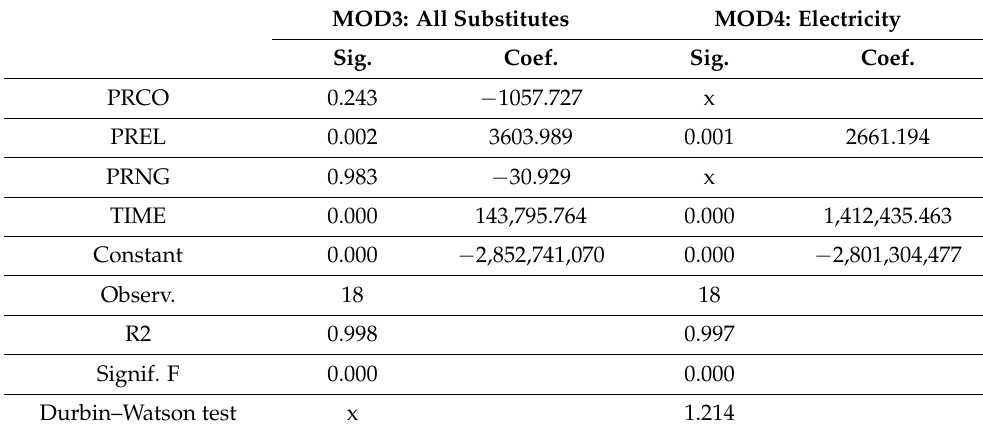
Table 6. Regression analysis—price model. MOD3: All Substitutes MOD4: Electricity Sig. Coef. Sig.